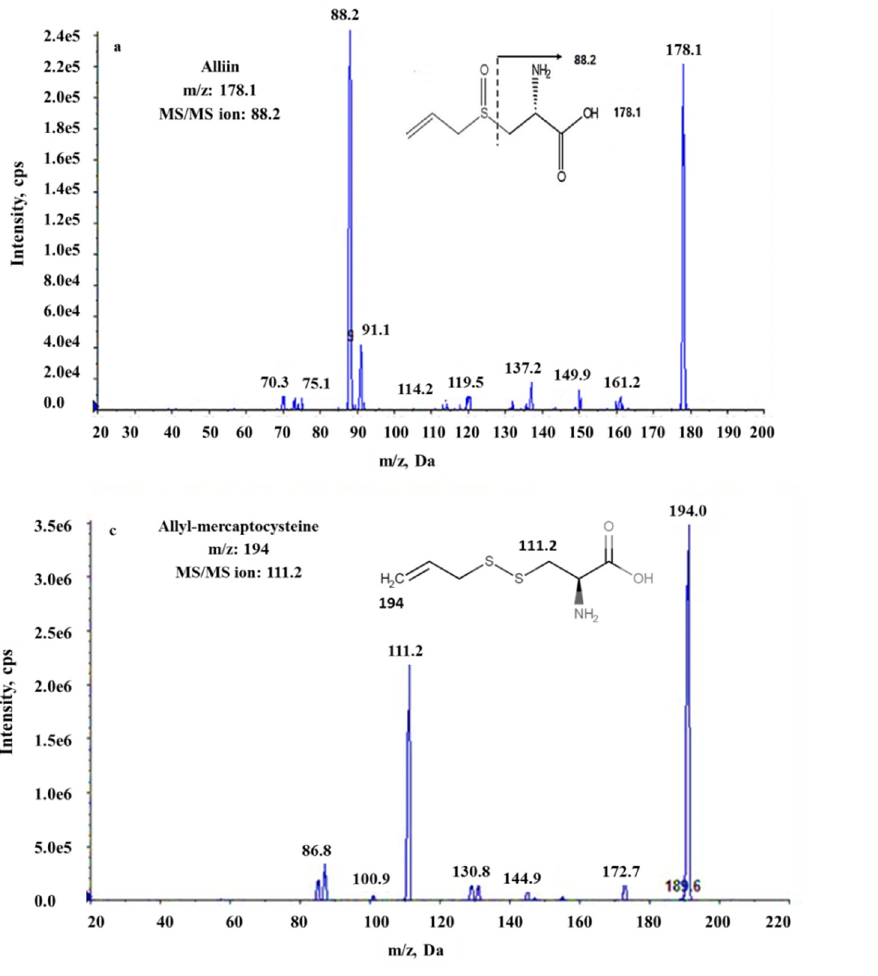
Figure 1. Product ion spectra and the main fragmentation pathway of [M + H]+ for alliin ( a ), allicin ( b ), allyl-mercapto-cysteine ( c ), and Glutamyl-(s)-Allyl-Cysteine ( d ).